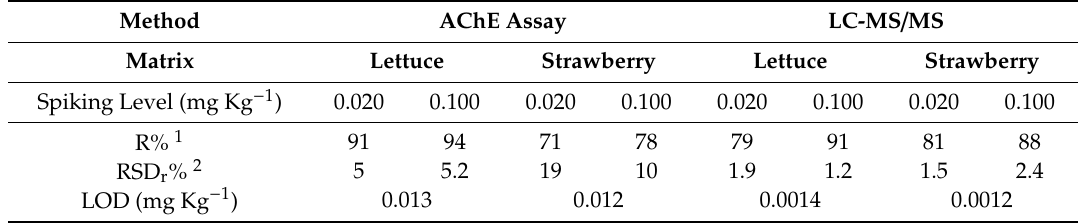
Table3. CarbofuranvalidationresultsinstrawberryandlettuceforAChEassayandLC–MS / MSmethod. Method AChE Assay LC-MS / MS Matrix Lettuce Strawberry Lettuce